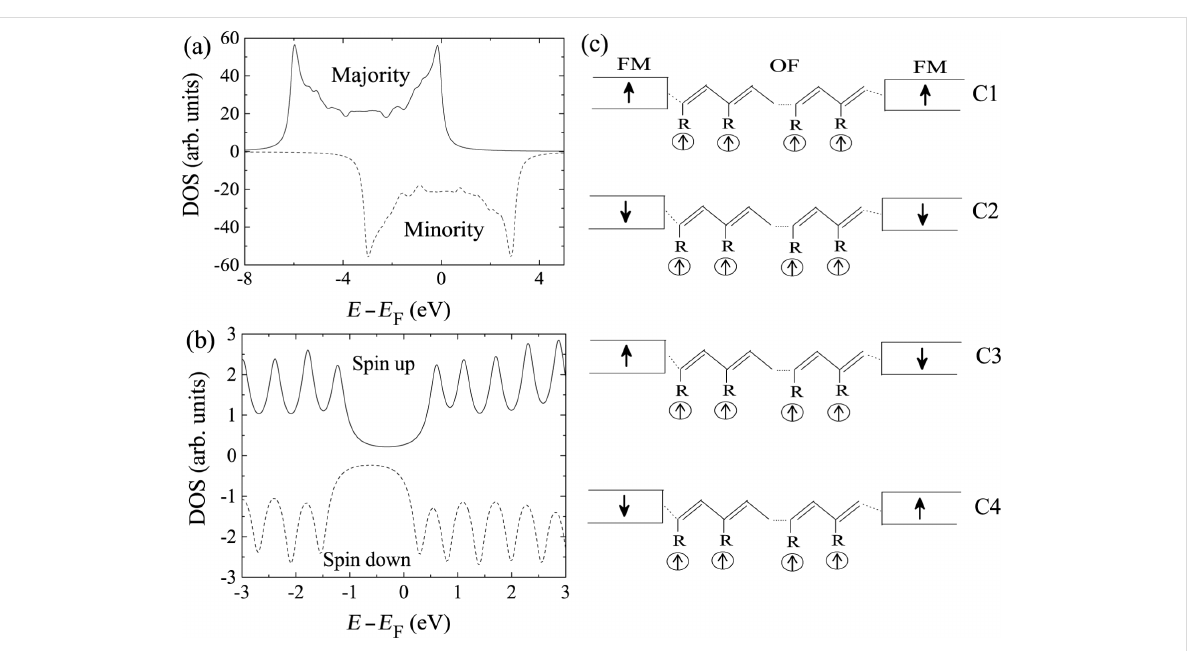
Figure 5: Density of states of (a) Co and (b) the OF poly-BIPO. The molecular length is 20 sites. (c) Schematic of the magnetization configurations C1, C2, C3, and C4 in the ferromagnet/OF/ferromagnet device. Reproduced with permission from [32], copyright 2014 AIP Publishing.